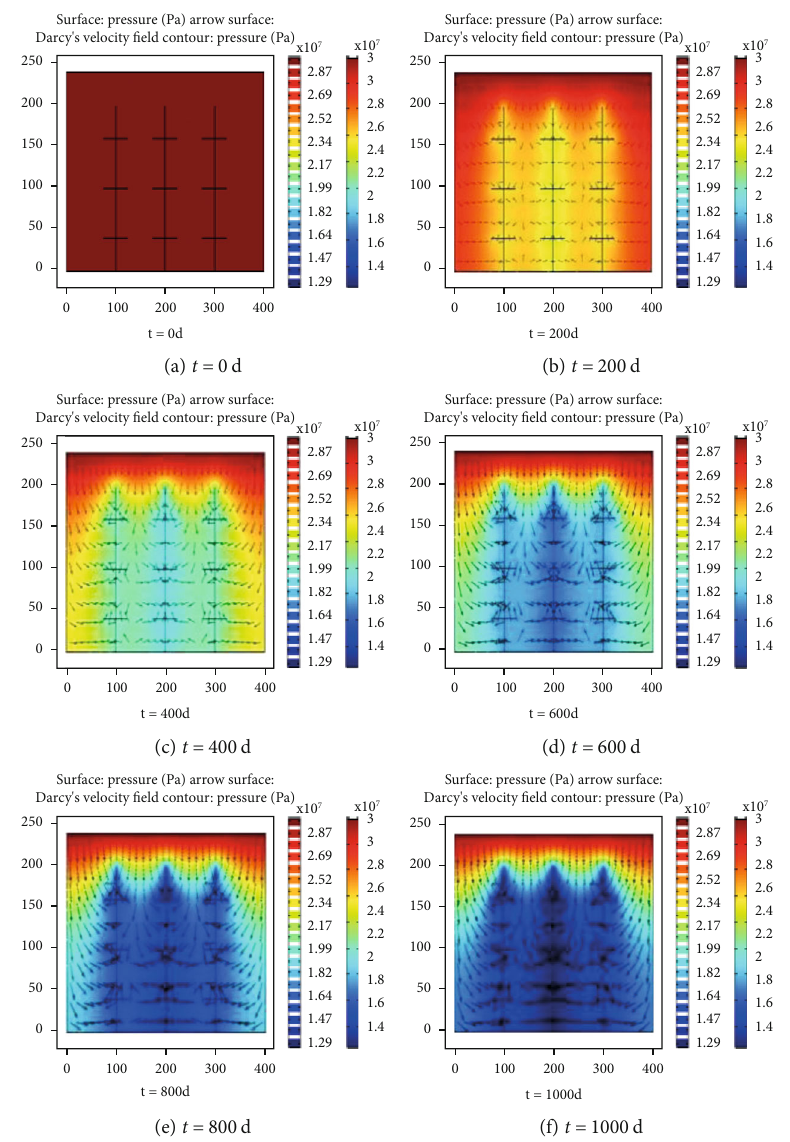
Figure 5: Distribution nephograms of reservoir pressure and velocity fi eld over time under constant gas